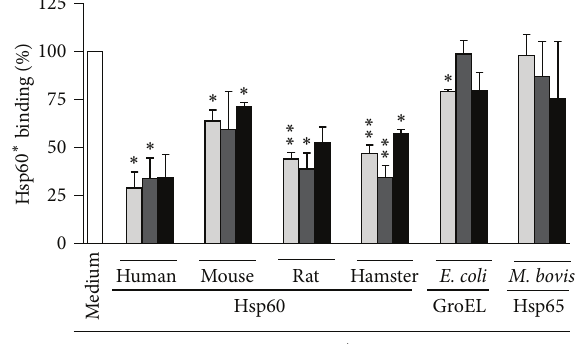
Figure 2: Characterization of the interaction of different Hsp60 species with preadipocytes from C57BL/6J, NOD, and NZO mice. C57BL/6J (light grey bars), NOD (dark grey bars), and NZO mouse-derived cells (black bars) were preincubated in the absence (Medium) or presence of 1 𝜇 M unlabeled eukaryotic or prokary- otic Hsp60 species (human, mouse, rat, hamster, E. coli, and M. bovis ), followed by addition of 100nM human Hsp60-DyLight649 (Hsp60 ∗ ). Hsp60 ∗ binding was quantified by FACS analysis. Data represent residual Hsp60 ∗ binding as percent of the binding of Hsp60 ∗ in the absence of Hsp60 or OVA (set as 100%, white bar). The results are shown as means + SEM of ≥ three independent experiments. ∗ 𝑃 < 0.05 ; ∗∗ 𝑃 < 0.01 compared to Hsp60 ∗ binding in the absence of Hsp60 and